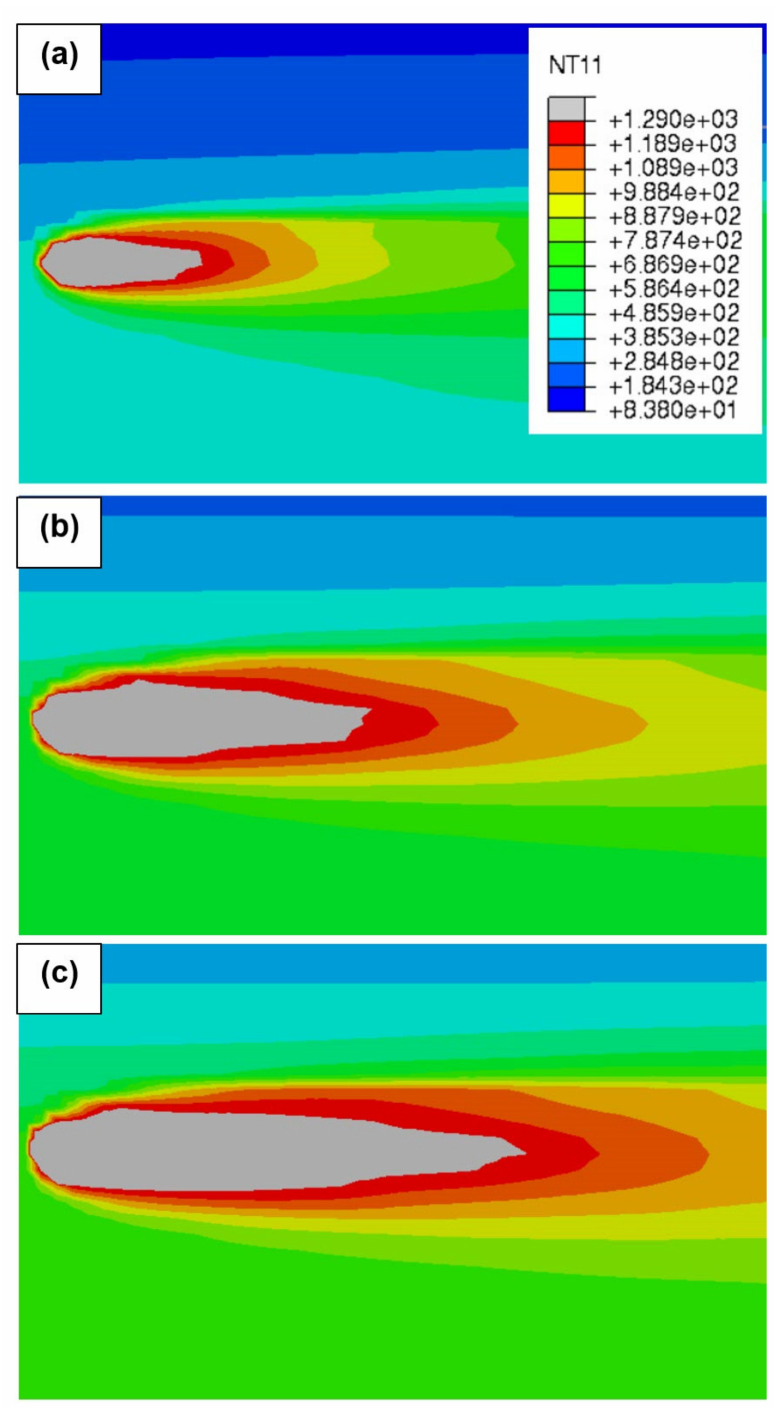
Figure 29. Melt pool size at ( a ) 140 W, ( b ) 220 W, and ( c ) 270